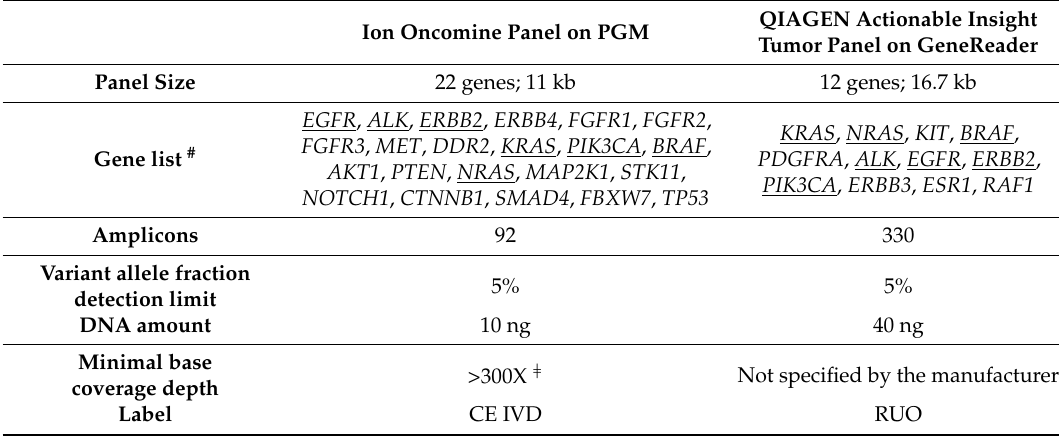
Table 1. Comparison of Ion Torrent Oncomine and GeneReader Actionable Insights targeted sequencing panels.